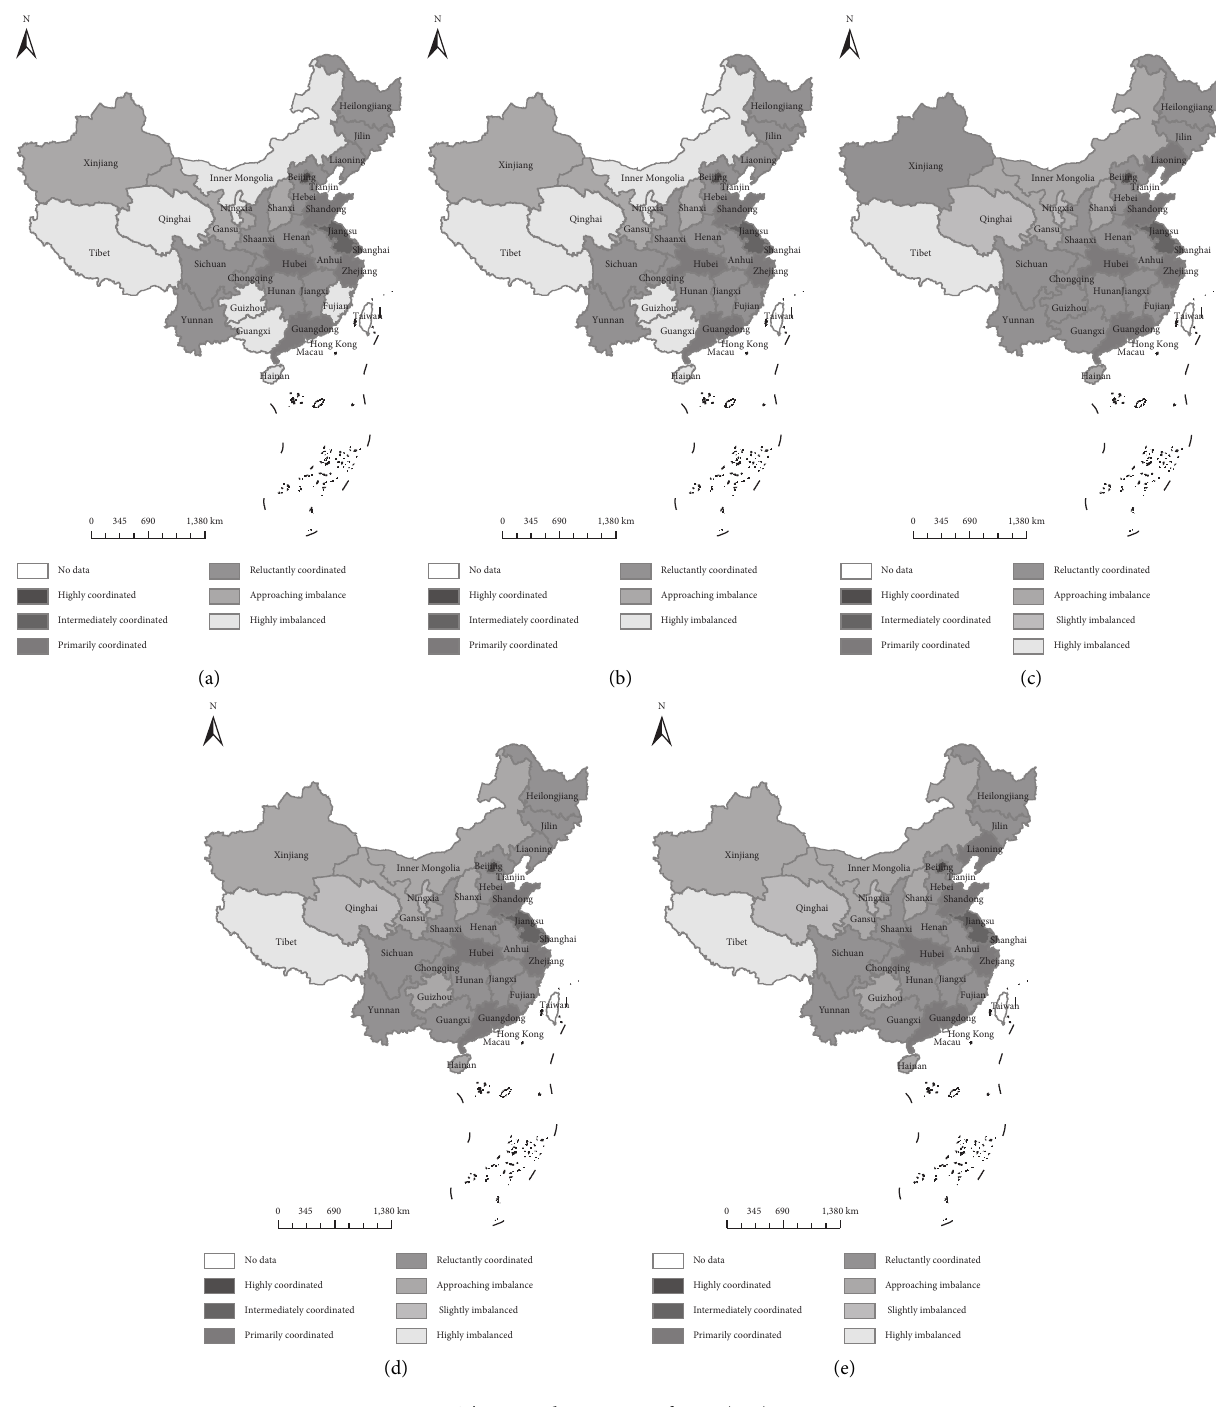
Figure 6: The spatial variation of CD: (a–e)